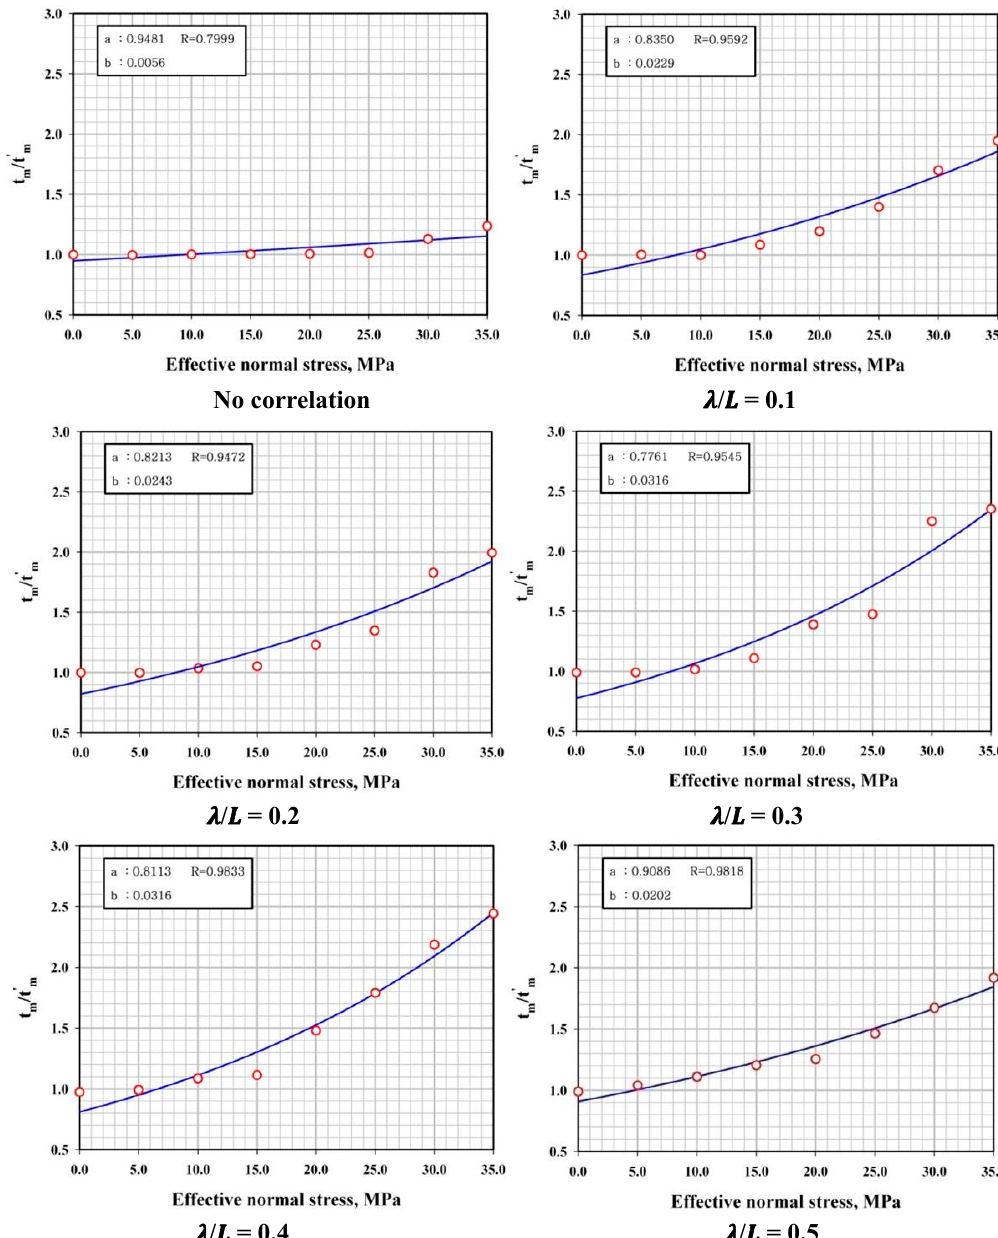
Figure 12. Relations between for (cid:2026) (cid:4593) and (cid:1872) (cid:3040) /(cid:1872) (cid:3040)(cid:4593) with (cid:2019)/(cid:1838) . The estimated parameters (cid:1853) and (cid:1854) did not show a tendency to increase or decrease apparently and regularly with variation of (cid:1872) (cid:3040) /(cid:1872) (cid:3040)(cid:4593) and (cid:2019) / (cid:1838) and had a tendency to be more or less independent. Table 2. Values of parameters (cid:1853) and (cid:1854) of Equation (10) determined based on (cid:2019)/(cid:1838) .